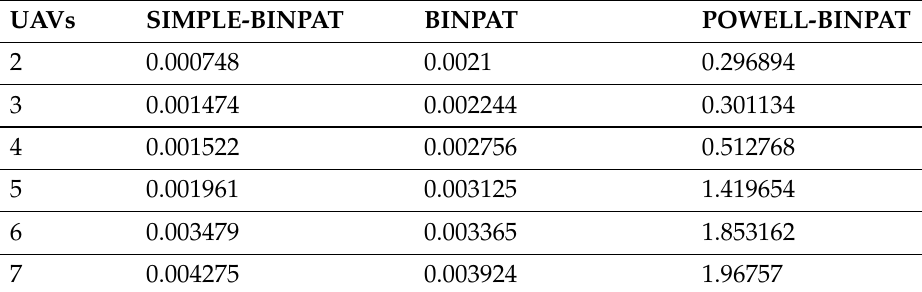
Table 3. Processing time results for different UAV number